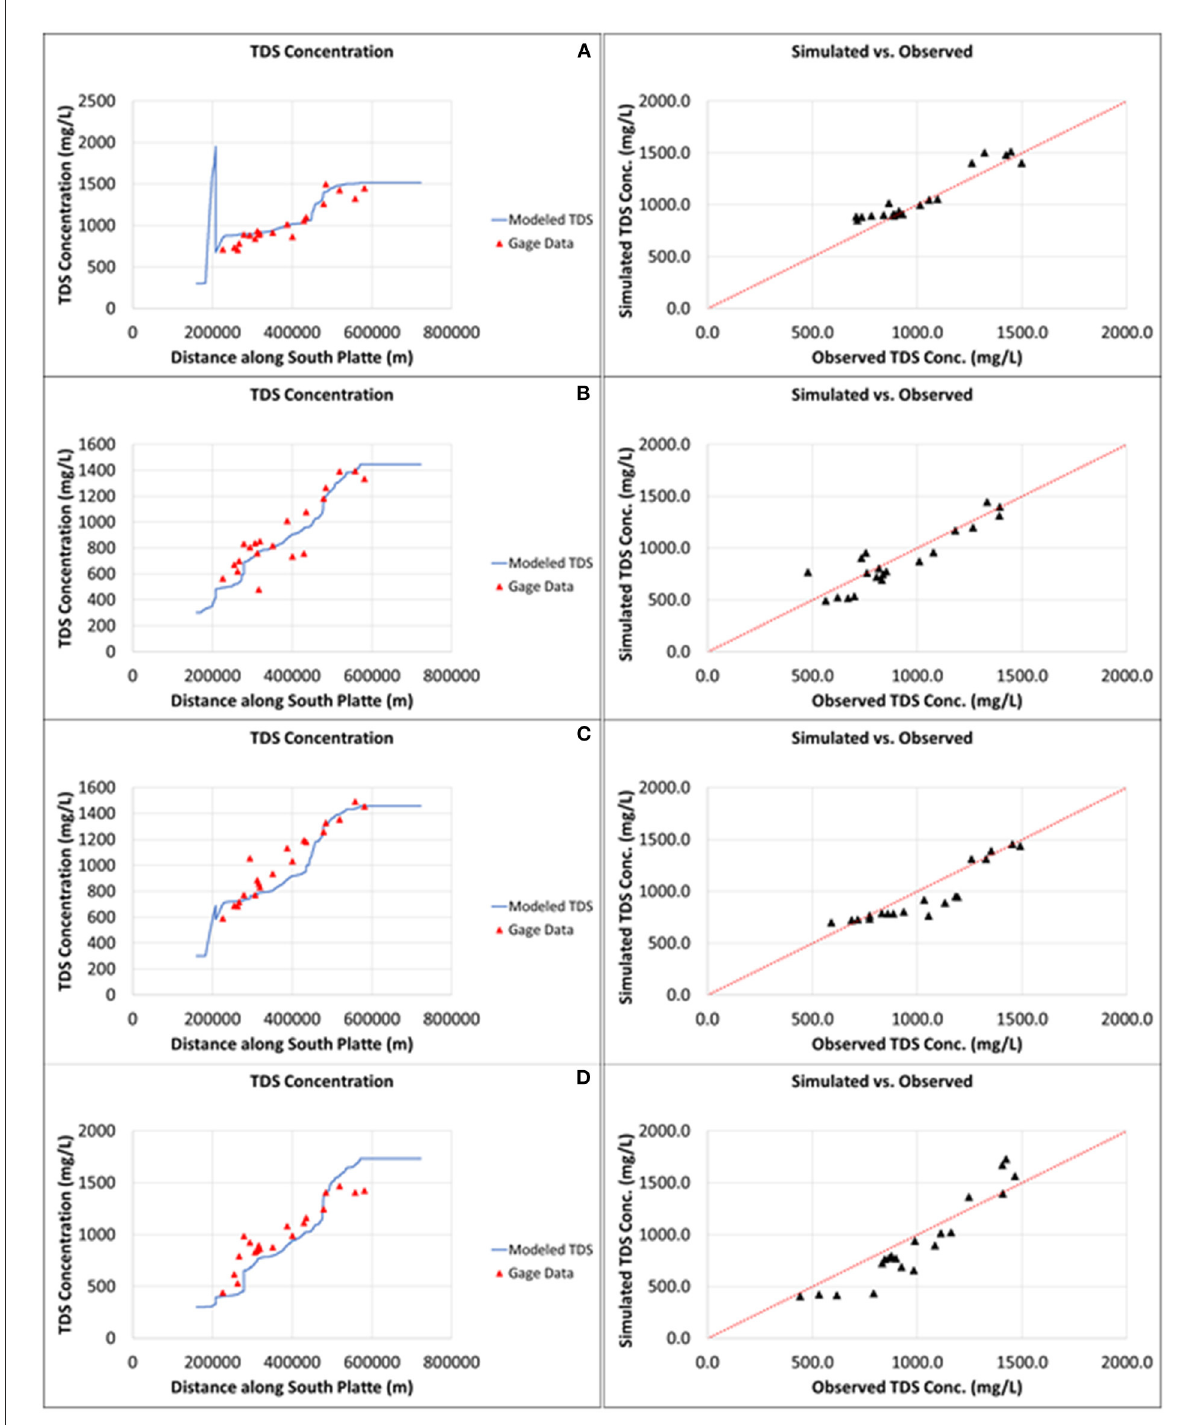
FIGURE8 Salt model results for (A) January 2006, (B) September 2005, (C) November 2006, and (D) August 2006, showing salt concentration (mg/L) at different locations in the river (charts on left) and 1:1 plots between observed and simulated flow concentrations (charts on right).